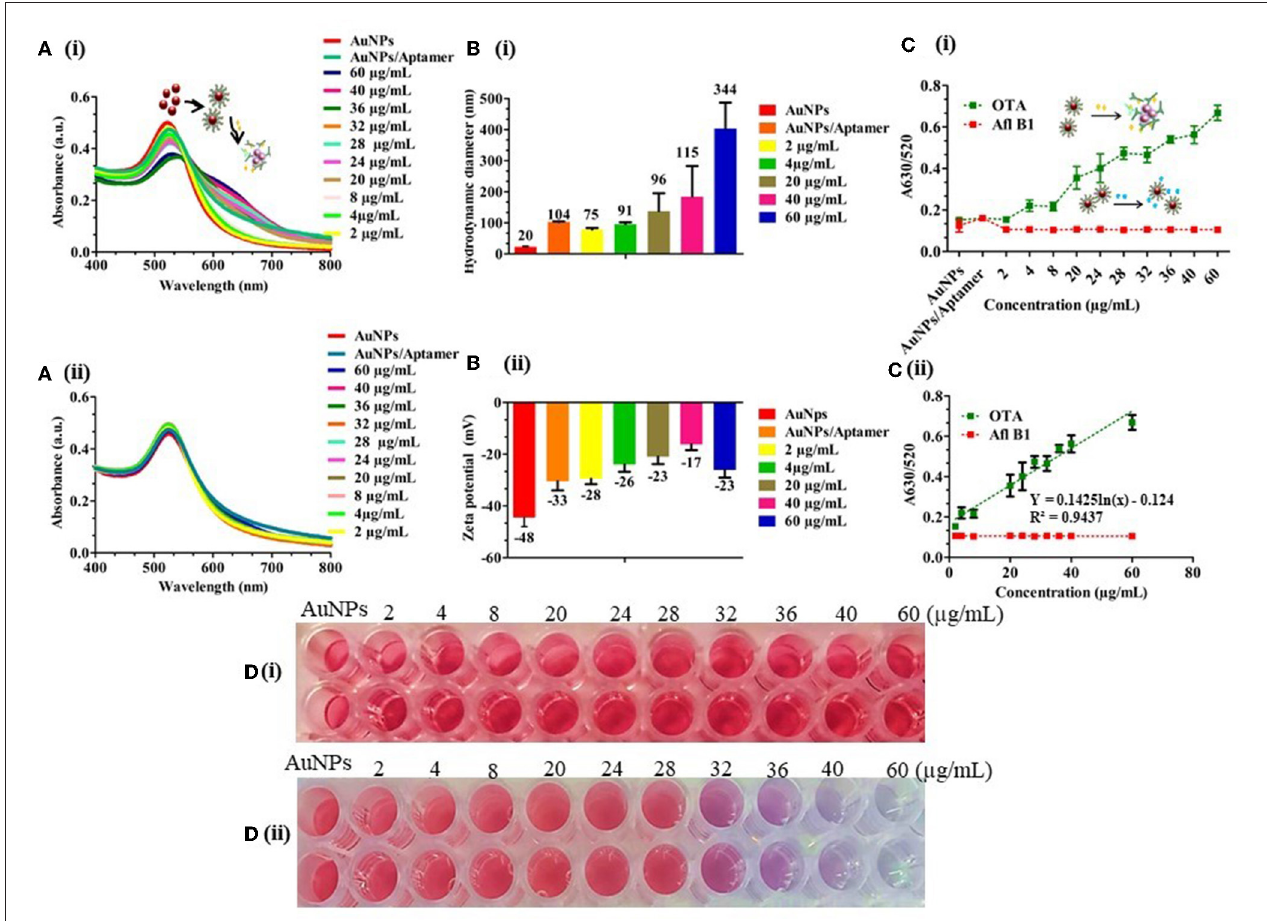
FIGURE 3 | Detection of OTA in spiked water samples; (A) (i) and (ii) UV-vis spectra of different concentrations of OTA and Afl B1 (60–2 µ g/mL) with OTA aptamer; (B) (i) and (ii) Hydrodynamic diameter and Zeta potential of the same which indicated decreased stability with an increased surface charge from − 48 to − 23mV; (C) (i) A 630 / 520 of OTA and Afl B1; (C) (ii) Calibration curve of A 630 / 520 of OTA and Afl B1; (D) (i) and (ii) Photograph of different concentrations of OTA and Afl B1 with OTA aptamer.